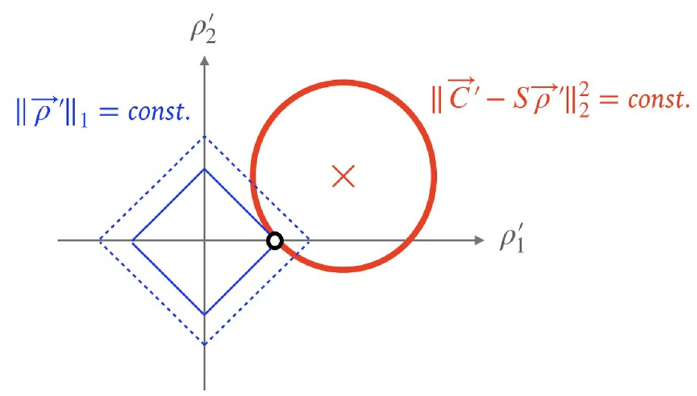
Figure 2 . Image of L 1 and L 2 regularizations in 2-dimensional (cid:26) 0 can be described by a line (a circle). The intersection point (open symbol) appears on the horizontal axis, where (cid:26) 0 is 2